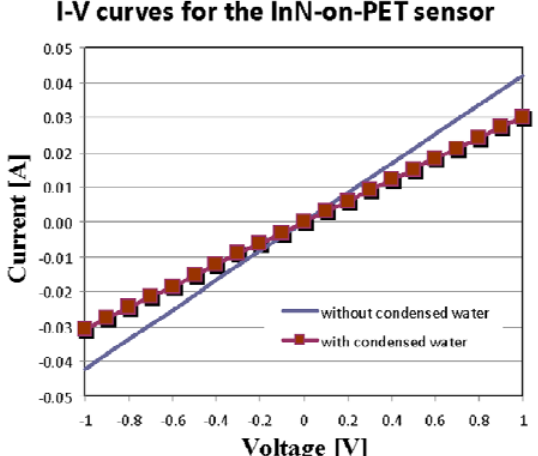
Figure 12. I–V characteristics of the InN-on-PET condensation sensor measured in regions b (with no condensed water) and c (with condensed water) of Figure 10